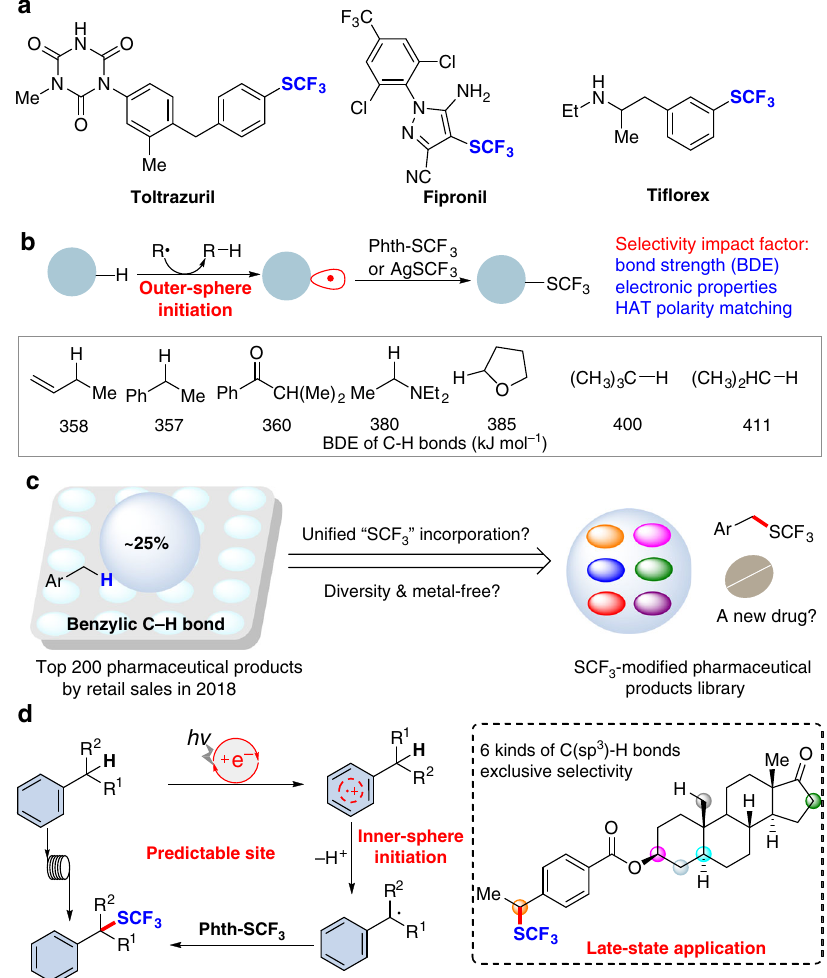
Fig. 1 The state-of-the-art strategies of precise C – H tri fl uoromethylthiolation. a The importance of tri fl uoromethylthiolated drugs in the market. b Previous strategies for C(sp 3 ) – H bond tri fl uoromethylthiolation via generation of key alkyl radicals by an outer-sphere radical initiation process. c The prevalence of the benzylic moiety in biologically important compounds. d Our work via inner-sphere radical initiation for precise benzylic C – H bond tri fl